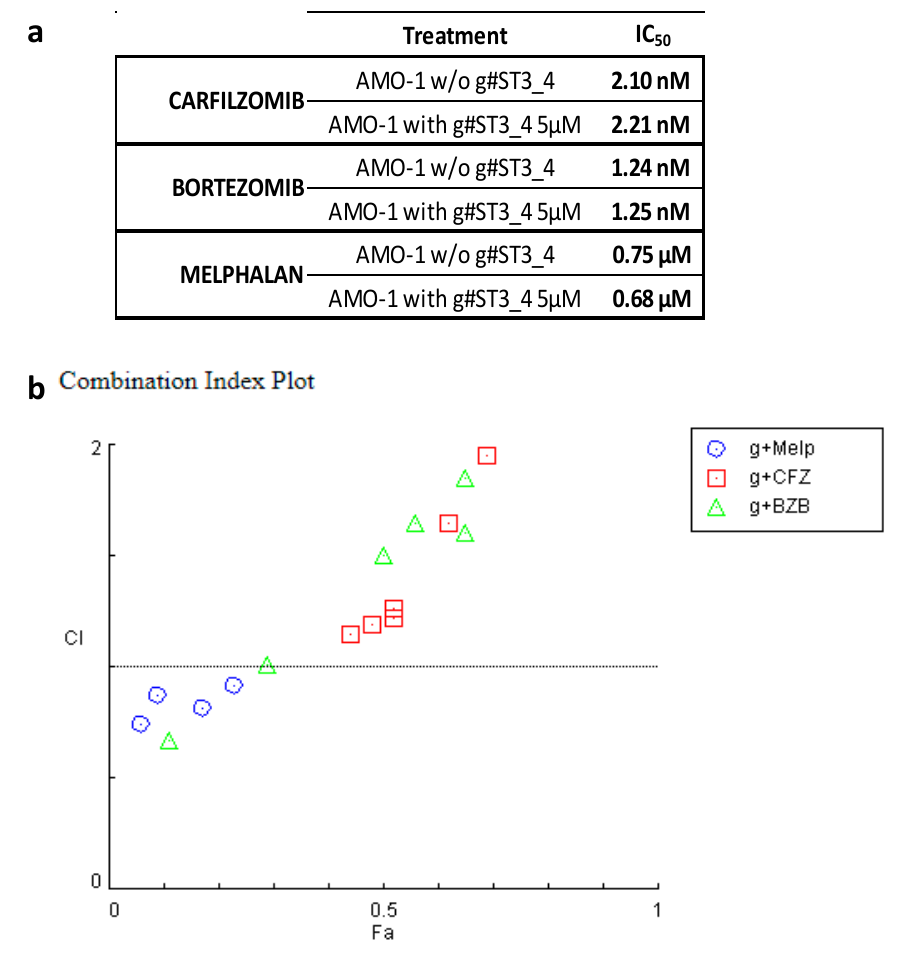
Figure 7. ( a ) Sensitivity of AMO-1 to BZB, CFZ, and Melph; IC 50 was evaluated 6 days after treatment. ( b ) Chou-Talalay plots (Fa-CI) showing combination indexes (CI) resulting from combined treatments of AMO-1 with g#ST3_4 gapmeR and CFZ, Melph, or BZB (6-day time point).